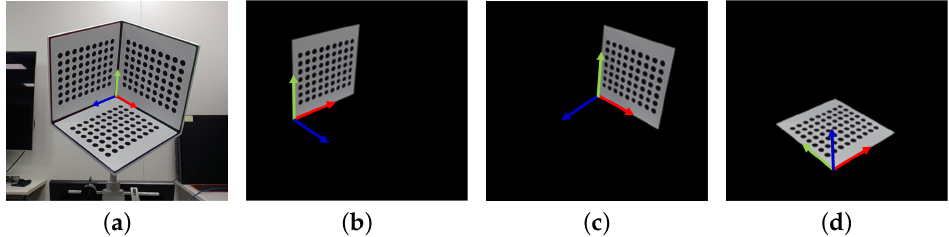
Figure 5. Onboard camera parameter calibration using a 3D calibration pattern of the calibration module: ( a ) onboard camera image; ( b ) the first 2D calibration pattern; ( c ) the second 2D calibration pattern; and ( d ) the third 2D calibration pattern. The red, green, and blue arrows represent the x-, y-, and z-axis,